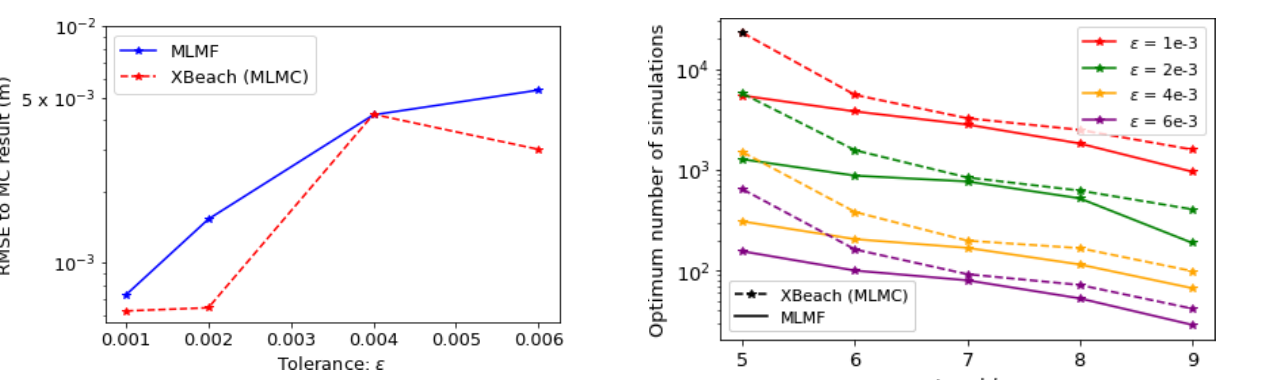
Figure 16. Error (RMSE) between the MLMF result and the Monte Carlo (MC) result for the Carrier–Greenspan test case as the tol- erance value (cid:15) in Eq. (14) is varied. This is compared to the error when varying (cid:15) in Eq. (B7) for MLMC with XBeach.